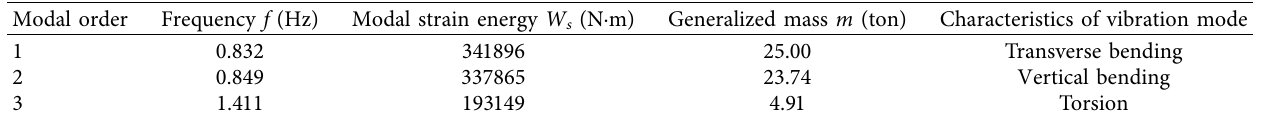
Figure 8: The first three mode shapes of the transmission line tower: (a) the first mode; (b) the second mode; (c) the third mode. Table 1: Properties of the transmission line